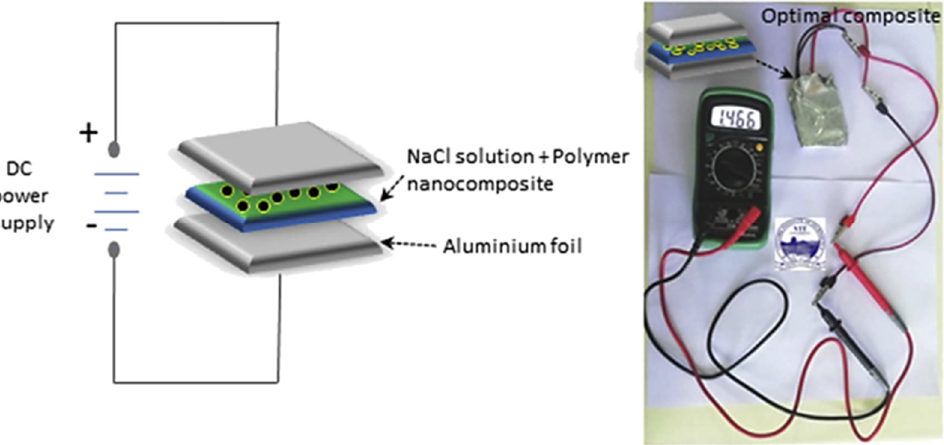
Figure 7. Illustration for PAN/PANI@G 1.5 wt.% based supercapacitor and its typical digital photograph of optimal nanocomposite verified for voltage generation [120]. PAN/PANI@G = polyacrylonitrile/polyaniline/graphene quantum dot. Reproduced with permission from Elsevier.